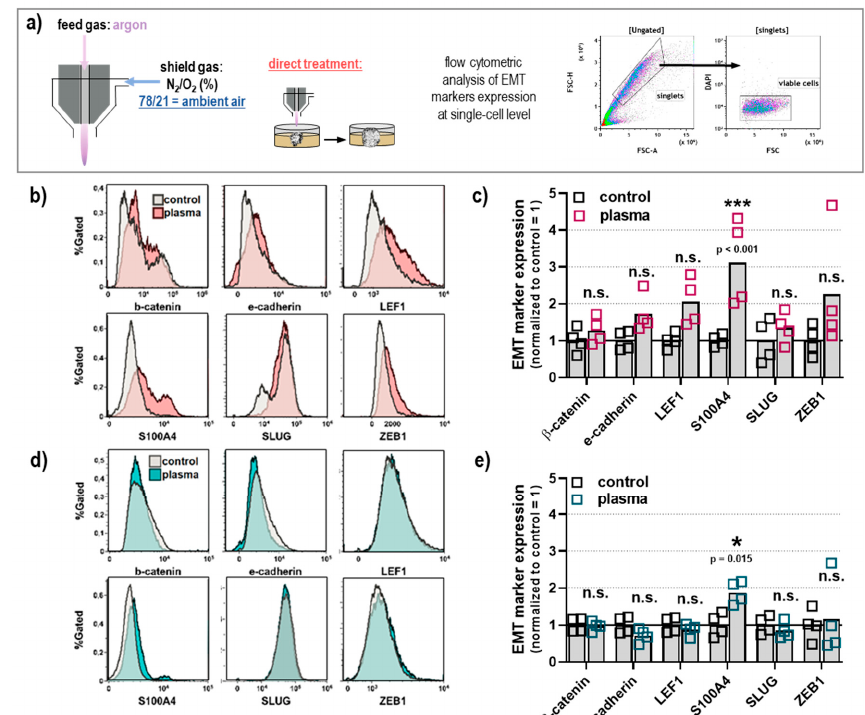
Figure 5. Plasma treatment under ambient conditions of melanoma spheroids had a minor e ff ect on EMT marker expression. ( a ) Schematic presentation of the plasma treatment (89 s) of spheroids embedded in matrigel, and subsequent flow cytometric analysis of the EMT markers β -catenin, E-cadherin, LEF-1, S100A4, SLUG, and ZEB1 at the single-cell level from dissociated spheroids; ( b ) representative fluorescence overlay histograms from flow cytometry of MNT-1 cells; ( c ) quantitative analysis of flow cytometry data from MNT-1 cells; ( d ) representative fluorescence overlay histograms from flow cytometry of SK-MEL-28 cells; ( e ) quantitative analysis of flow cytometry data from SK-MEL-28 cells. Data are mean with individual values of two independent experiments with two replicates each. Statistical analysis was performed using two-way analysis of variances with Sidak post hoc testing and with p < 0.05 (*) and p < 0.001 (***). n.s. = not